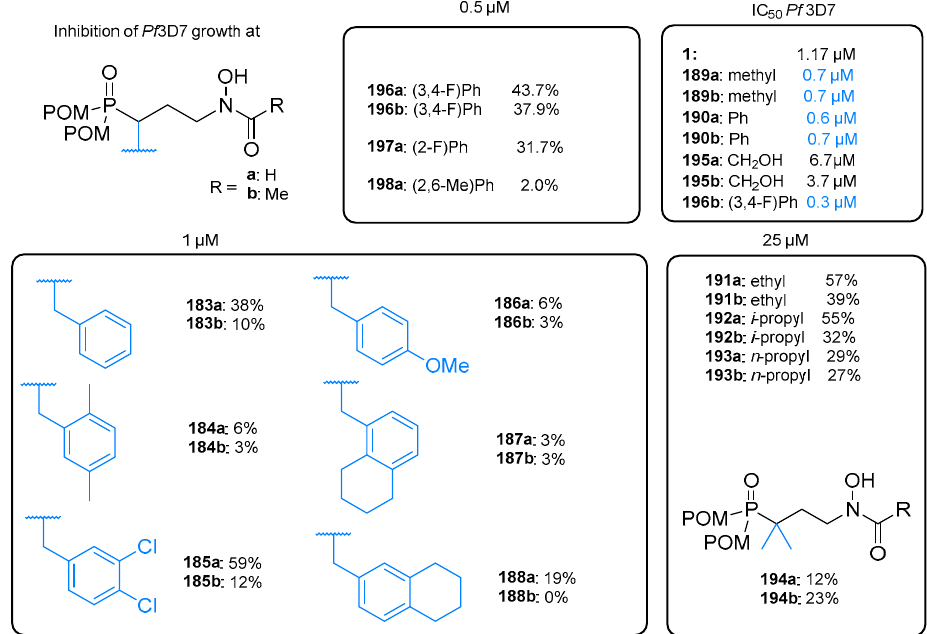
Figure 36. Antiplasmodial activity of α -benzyl and α -alkyl analogs 183 – 198 . Derivatives were screened for their inhibition of P. falciparum 3D7 growth at 0.5, 1 and 25 µM. The Kurz group also synthesized phosphonate ester prodrugs of reverse β -oxa and carba analogs with a 3,4-difluorophenyl substituent in the α -position of the linker ( 110a , 110b and 114b , Figure 37). The phosphonic acid group of the inhibitors 110a , 110b and 114b was masked with n -butyloxycarbonyloxymethyl ( A ), POC ( B ) and POM ( C ) prodrug moieties (Figure 37). All prodrugs of this series ( 199 – 205 , Figure 37) were excellent to potent inhibitors of Pf 3D7 and Dd2 with IC 50 values between 8 and 49 nM and were more potent than their respective parent compounds (IC 50 = 0.075–0.54 µM) [37]. Significant growth inhibition was achieved by the introduction of the POM prodrug moiety unit into the β -oxa analog 205 with an IC 50 value of 13 nM against Pf 3D7. 205 was more than 40-fold more active than the parent compound 114b (IC 50 value of 0.54 µM). The antiplasmodial activity of 114b was further surpassed by the carba analog 203 with an excellent IC 50 value of 8 nM. The inhibitors with an n -butyloxycarbonyloxymethyl prodrug unit ( A ) outperformed the inhibitors with a POC prodrug unit ( B ), which could be due to less steric hindrance